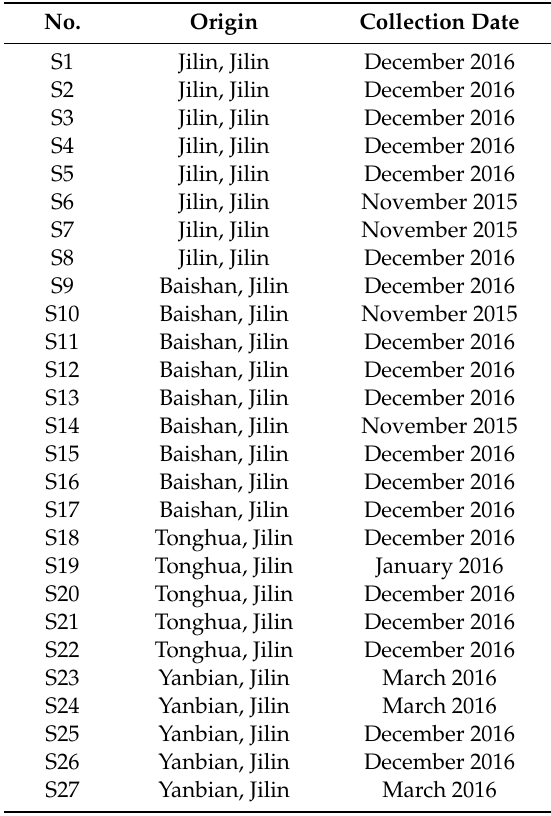
Table 1. Origin and collection date of Oviductus Ranae samples.